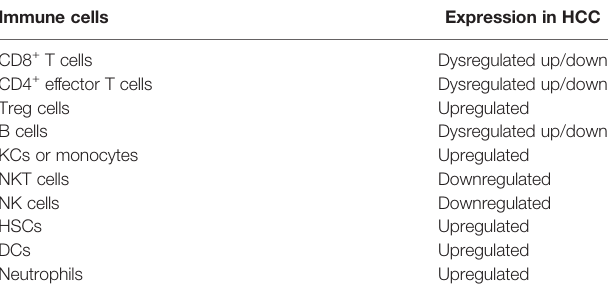
TABLE 1 | Expression of innate and adaptive immune cells. Immune cells Expression in